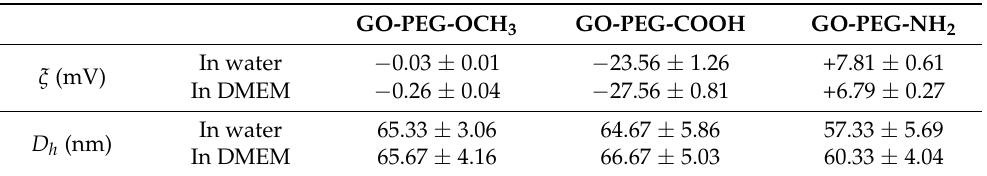
Table 1. Zeta potential ( ξ ) of water-dispersed PEG-GO in water (pH = 7.00) and DMEM, and hydrodynamic diameter ( D h ) for PEG-GO samples (mean ±